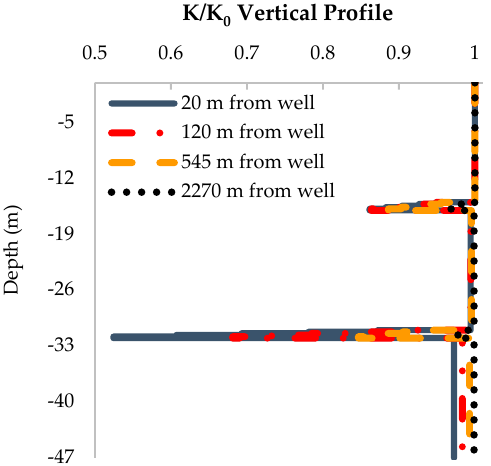
ff erent locations within the aquifer system. Hydrology 2019 , 6 , x